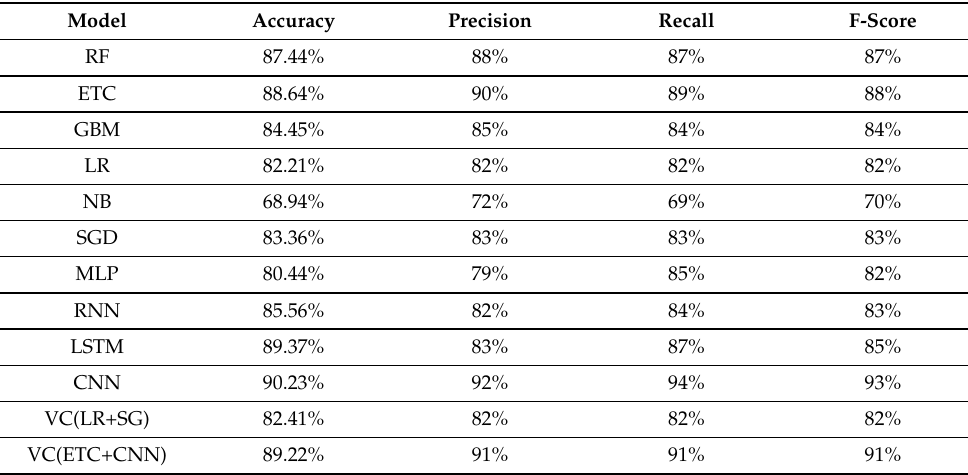
Table 5. Comparison of classifiers using